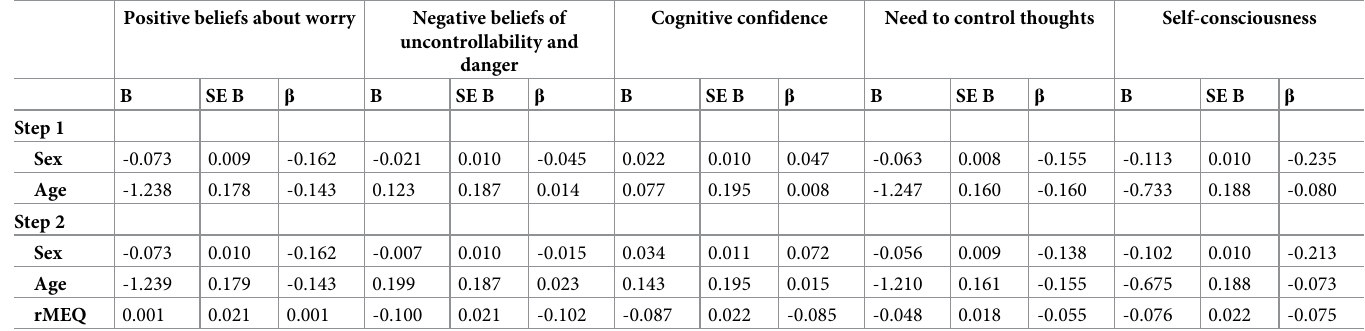
Table 5. Multiple linear regression model coefficients for the different metacognitions assessed through